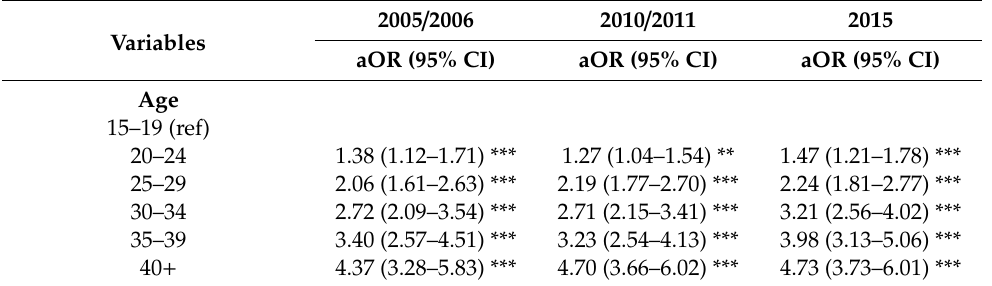
Table 3. Multivariate associations between demographic, socioeconomic, behavioral risk factors and overweight and obesity among women of reproductive age (15–49 years), Zimbabwe,